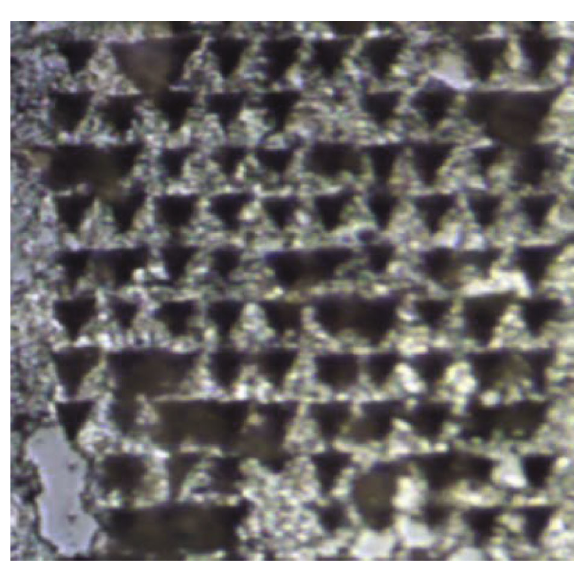
Figure 8: Indentation bitmap.